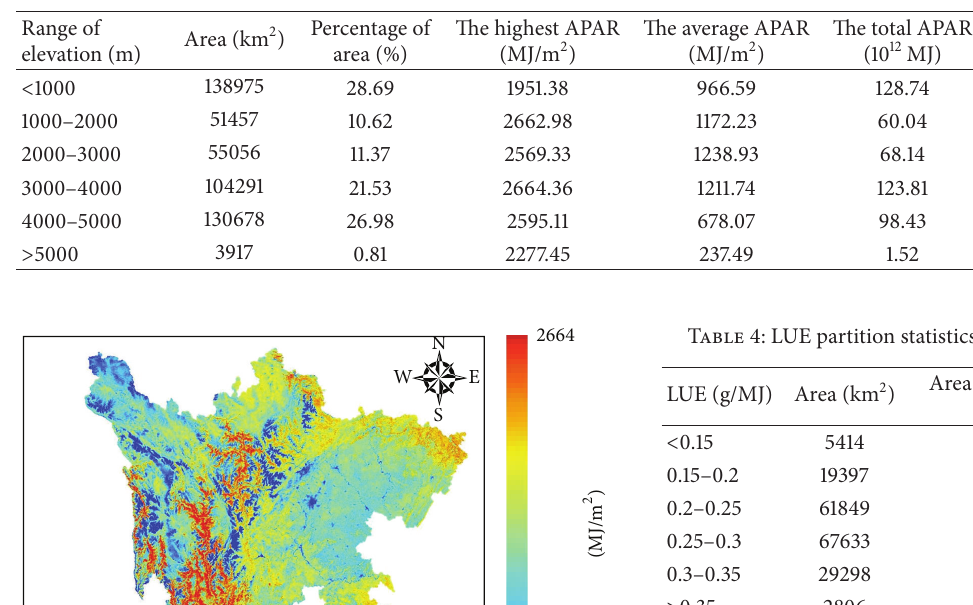
Table 3: Distribution of APAR for different ranges of elevation for Sichuan province in 2011.